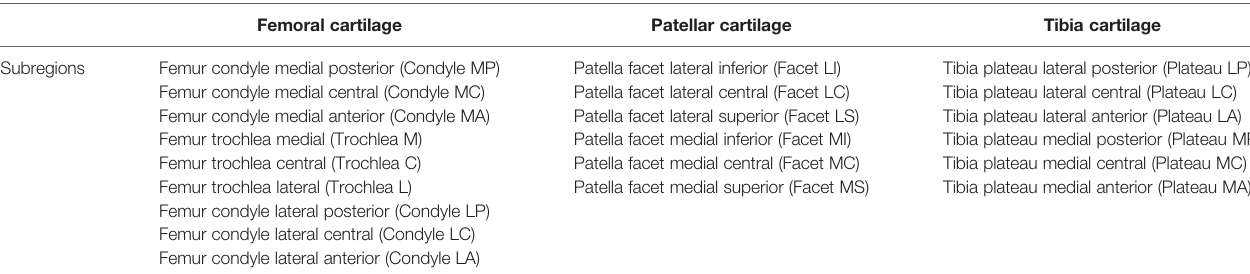
TABLE 1 | Cartilage sub-regions of the knee.